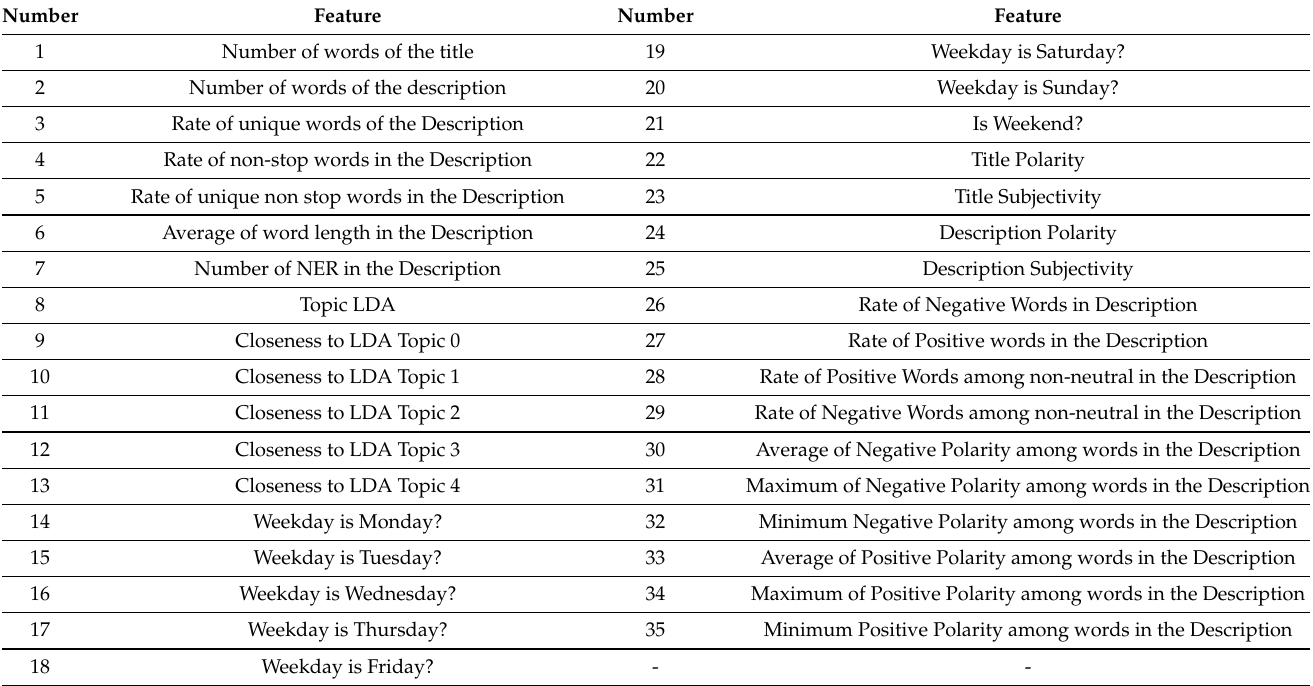
Table 5. Textual features collected from the title and the description of